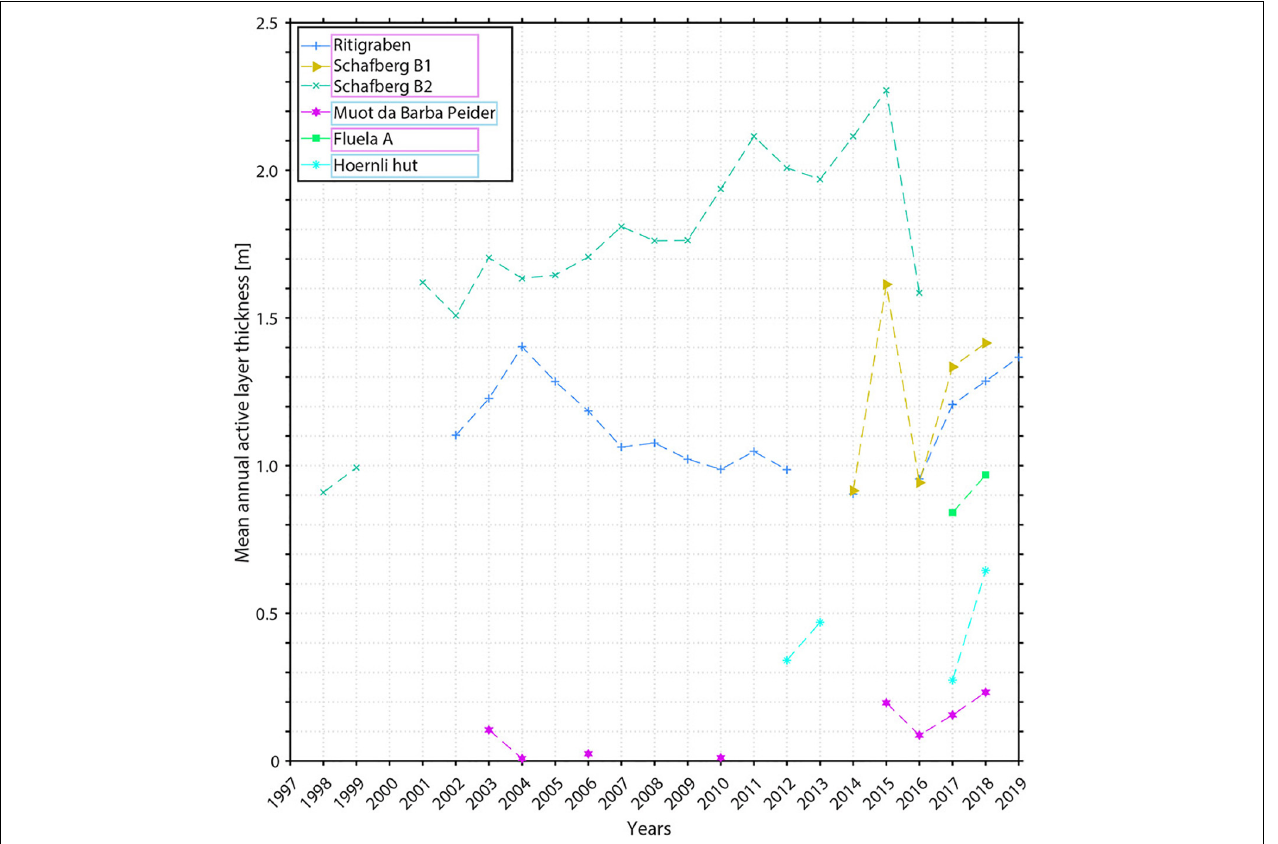
FIGURE 9 | Mean annual active layer thickness calculated for all boreholes with permafrost. Mean annual active layer thickness could not be calculated for sites lacking sensors in the active layer (partly Muot da Barba Peider B1, see Figure 8 ). The coloured frames indicate the ice content of the boreholes: pink for ice-rich, and light blue for ice-poor